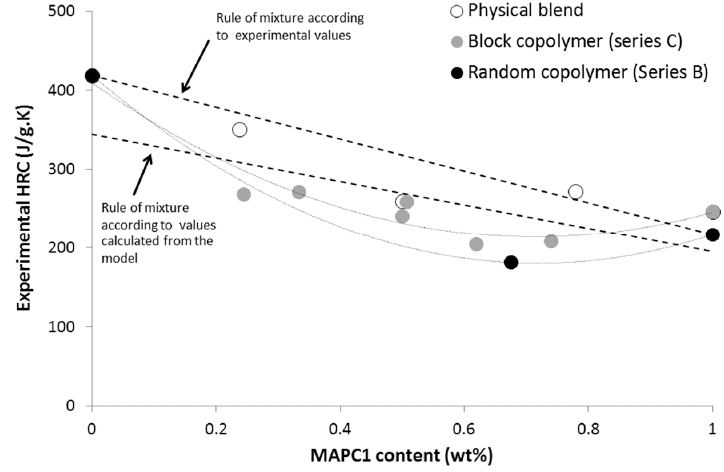
Figure 10. Experimental HRC versus MAPC1 content for various polymers (from series B and C).